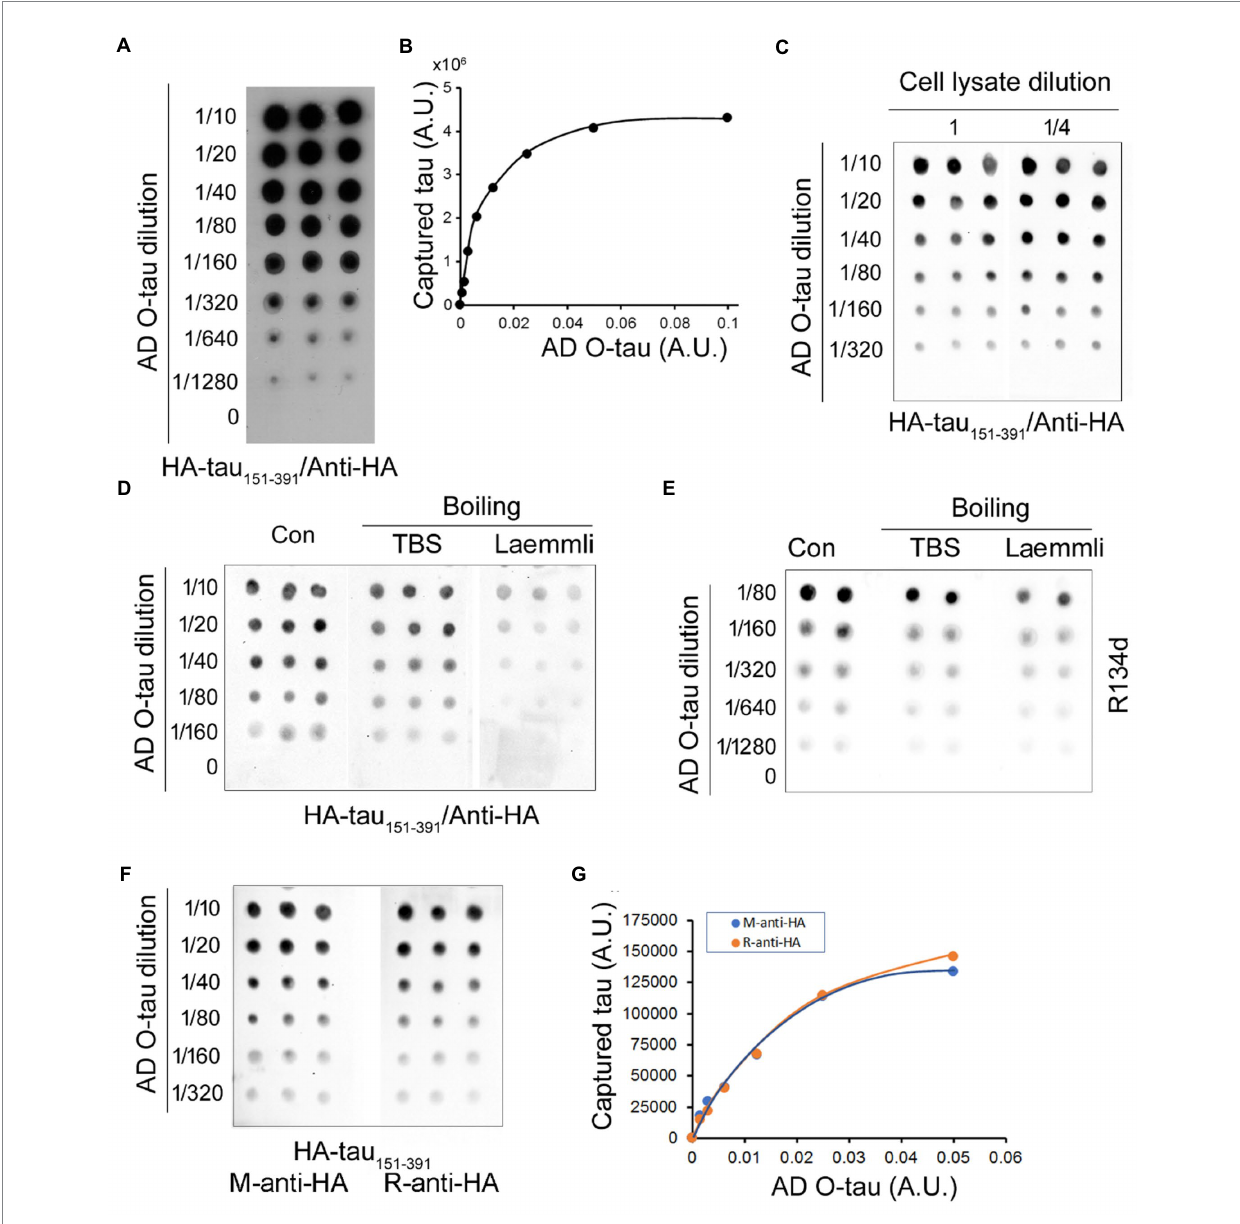
FIGURE 1 Assessment of tau seeding activity by the tau capture assay. (A,B) AD O-tau captured tau 151-391 effectively. Various amounts of AD O-tau were applied onto NC membrane in triplicate. The membrane was blocked with 5% milk and incubated with the lysate of HEK-293FT cells expressing HA-tau 151-391 . Captured tau was developed with anti-HA followed by HRP-2 nd antibody and ECL (A) . The levels of captured tau were plotted against amounts of AD O-tau (B) . (C) Limited dilution of HEK-293FT cell lysates did not affect the levels of captured tau. NC membranes applied with various amounts of AD O-tau in triplicate were incubated with the lysate or ¼ diluted cell lysate containing HA-tau 151-391 after blocking. Captured tau was analyzed as described in panel A. (D,E) Denaturing by boiling in Laemmli buffer partially inhibited the capability of AD O-tau to capture tau 151-391 . NC membranes applied with AD O-tau in duplicate or triplicate were boiled in Laemmli buffer or TBS for 5 min and then subjected to the capture assay (D) or immuno- dot blots (E) . (F,G) Anti-HA from mouse and from rabbit detected captured tau similarly. NC membrane applied with AD O-tau in triplicate was incubated with the cell lysate containing HA-tau 151-391 . Captured tau was developed with monoclonal mouse anti-HA or polyclonal rabbit anti-HA (F) and plotted against the amounts of AD O-tau (G) . A.U., arbitrary